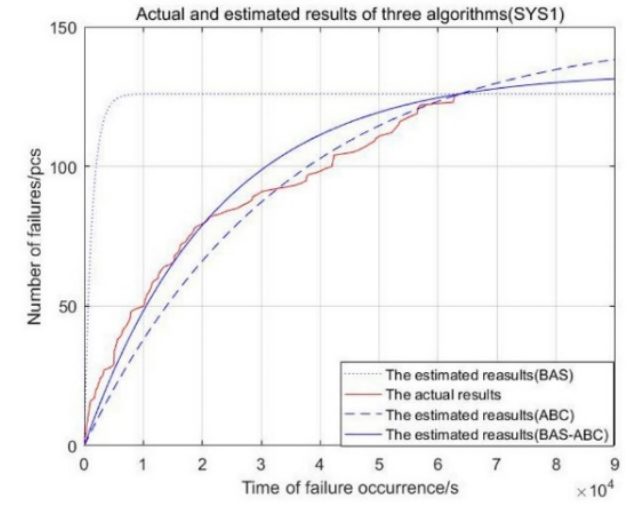
Figure 3. Actual and estimated time of failure occurrence of three algorithms (SYS1).